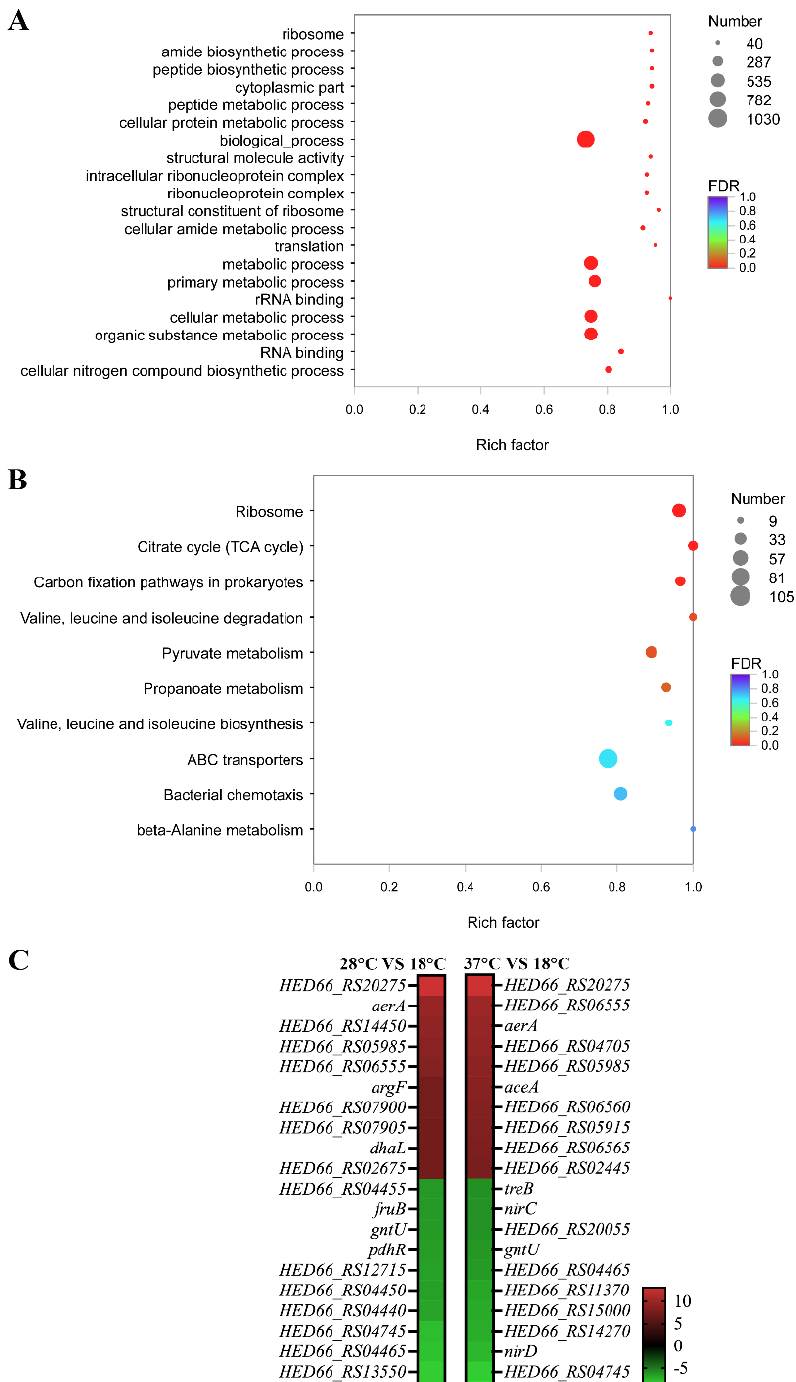
Figure 3. Analysis of differentially expressed genes. ( A ) GO terms of all the DEGs were classified based on their molecular functions, involvement of biological processes, and cellular components. The size of the dot indicates the number of genes/transcripts in this GO term, and the color of the dot corresponds to different FDR ranges. ( B ) KEGG enrichment of all DEGs. The size of the dot indicates the number of genes in this pathway, and the color of the dot corresponds to different q ‐ value ranges. ( C ) Heat map of the 20 genes most significantly affected at 28 °C or 37 °C (10 genes with the highest up ‐ regulated ratio and 10 genes with the highest down ‐ regulated ratio). Values represent log2 folds. Colors based on log ‐ transformed transcripts FPKM mean values. Blue and red indicate decreased and increased expression, respectively.